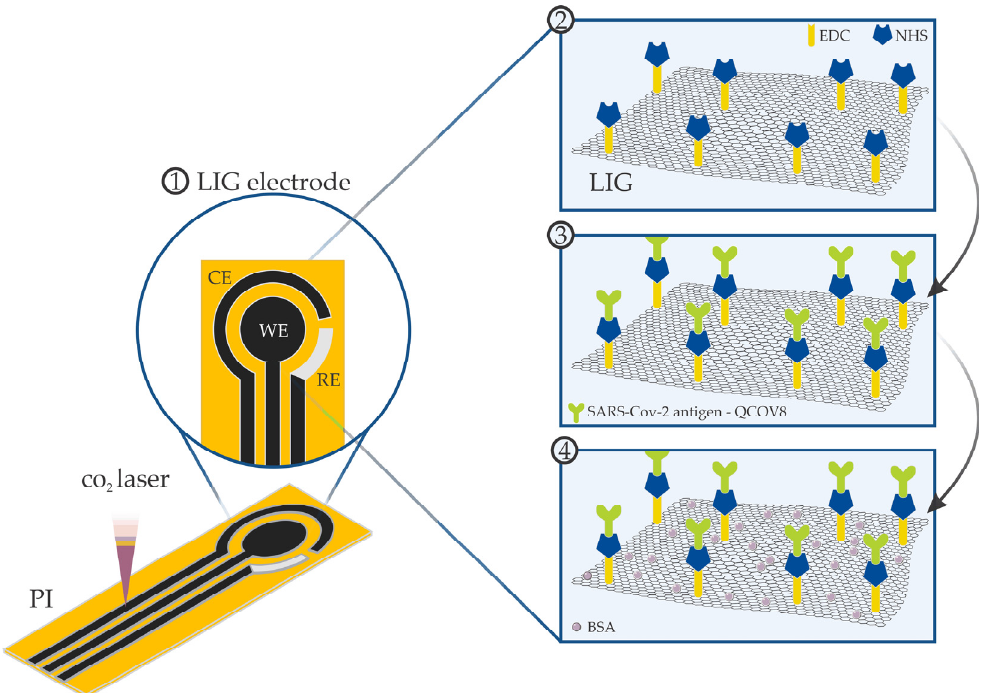
Figure 1. Illustration of the LIG-based electrode fabrication using the direct laser writing process on PI sheets.